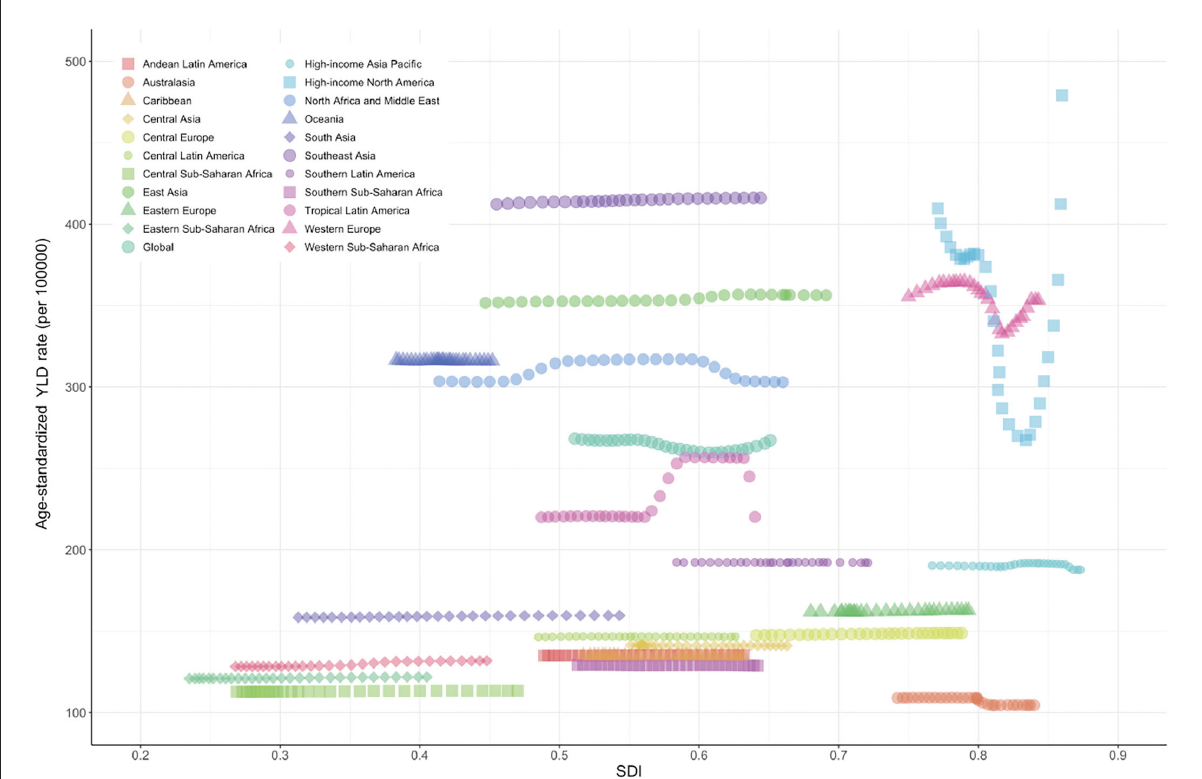
FIGURE4 Age-standardized YLD rate of neck pain for 21 regions according to SDI in 2019. Thirty points were plotted for each region and observed age-standardized prevalence for each region is shown. Generated from data available at http://ghdx.healthdata.org/gbd-results-tool. YLD, years lived with a disability; SDI, socio-demographic